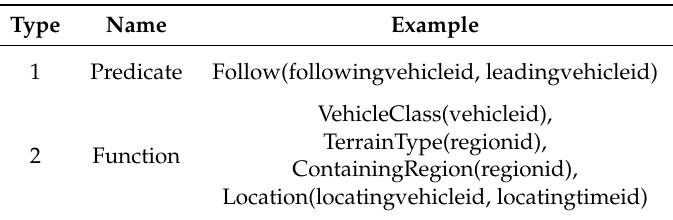
Table 1. Resident Node Types on